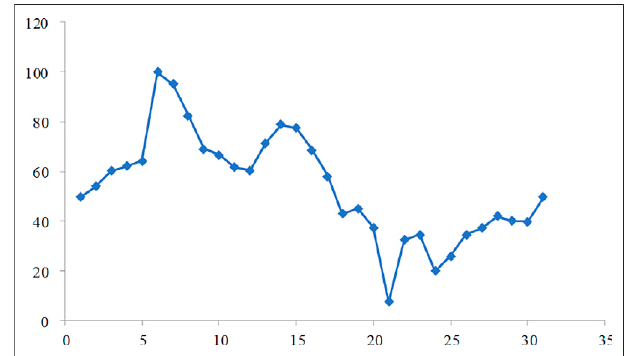
FIGURE 3 | CDBA solution for Oliver30.